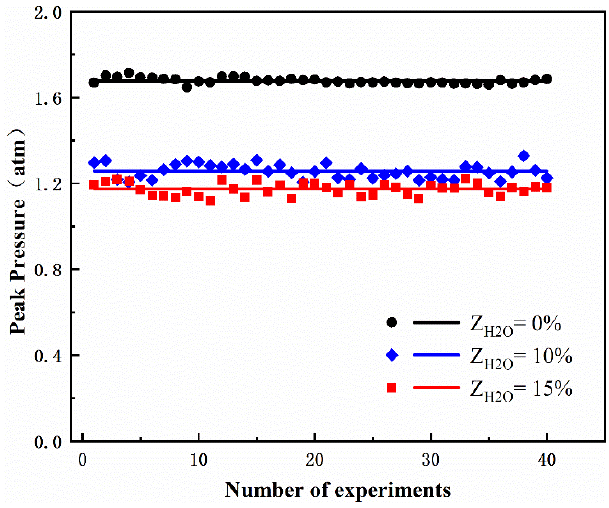
Figure 4. Statistics of peak pressure at different steam concentrations.